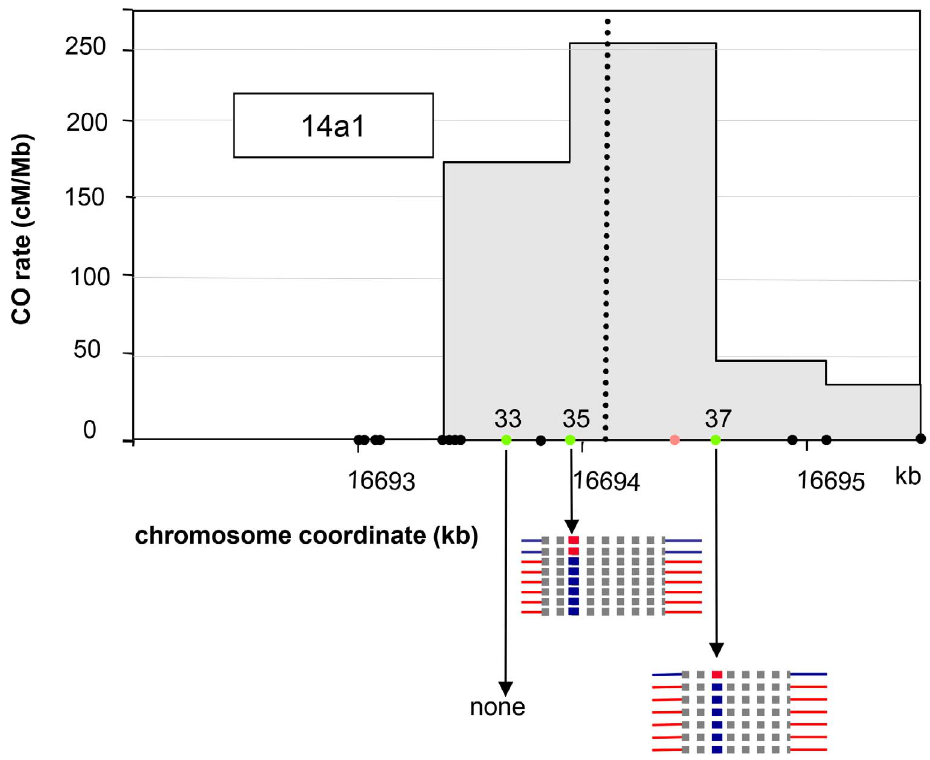
Figure 5. NCO events at 14a1. The SNPs # 33, # 35 and # 37 are indicated by filled green circles. The polymorphisms are indicated by filled black circles along the chromosome coordinate axes. The position of the microsatellite located between # 35 and # 37 is indicated as an orange circle. Thick blue or red horizontal lines: converted SNPs, Thick dotted grey horizontal lines: interval in which NCO tract ends are located. Blue: Col; Red: L er.